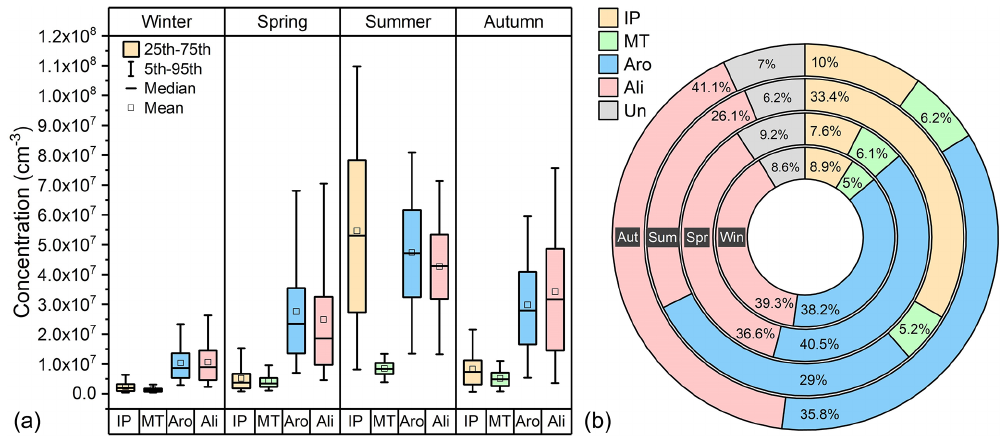
Figure 4. Concentration (a) and fraction (b) of source-classified OOMs in four seasons. The abbreviations IP, MT, Aro, Ali, and Un stand for IP OOMs, MT OOMs, aromatic OOMs, aliphatic OOMs and undistinguished OOMs, respectively. Win, Spr, Sum, and Aut represent winter, spring, summer, and autumn,